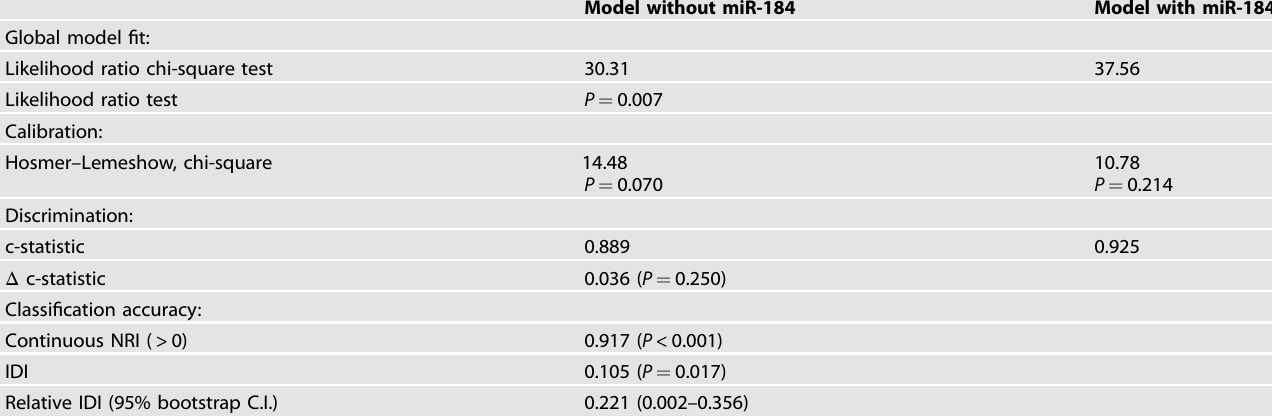
Table 4. Additional contribution of miRNA-184 to a clinical model for the prediction of cardiac